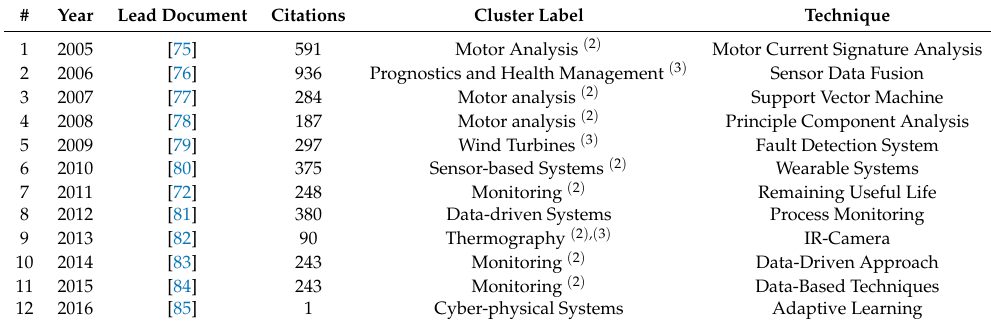
Table 8. Research field and technique of the most cited papers or corresponding clusters